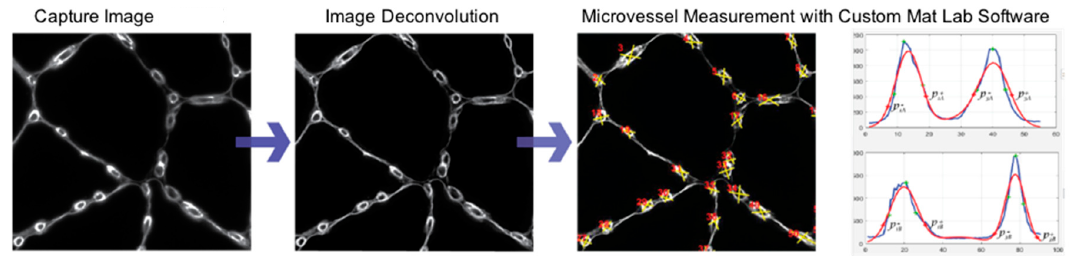
Figure 2. Measurements of Micro-vessel Architecture. Slide specimens labeled with anti-Collagen IV Ab were imaged with a 40 × objective and deconvoluted with AutoQuant ® software for reduced light scatter and improved micro-vessel delineation. For each micro-vessel (overall diameter ≤ 15 µ m), two perpendicular line profiles of Collagen IV fluorescence intensity were generated with a custom MatLab program. Gaussian distributions (red) were fitted to the raw fluorescence intensity data (blue). The thickness of the Collagen IV ring (basement membrane) for each micro-vessel was determined as the average distance at the 95% confidence interval for each of the Gaussian curves. The inner diameter of the basement membrane was determined as the mean of the distances between the pairs of Gaussian curves at the locations of their 95% confidence intervals.